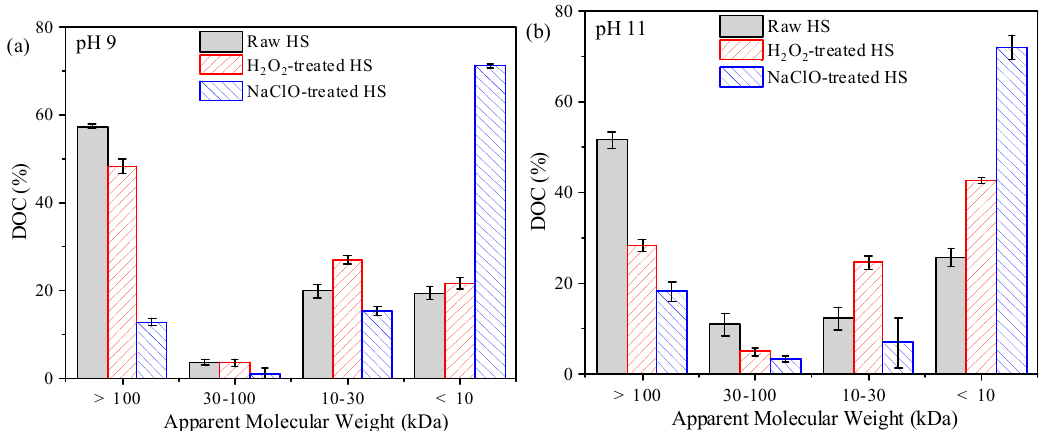
Figure 5. Apparent molecular weight distributions of HS before and after reacting with H 2 O 2 and NaClO: ( a ) pH 9, ( b ) pH 11. The ratio of oxidant to DOC: 13:1; reaction time: 6 h.